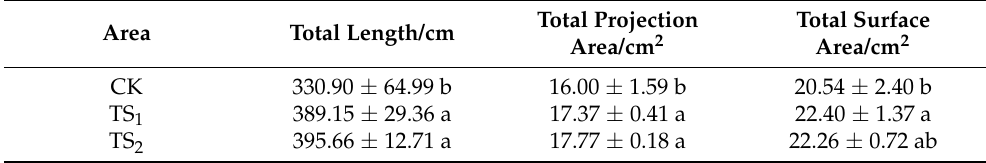
Table 3. Effects of WCTRZSCS on tomato roots.